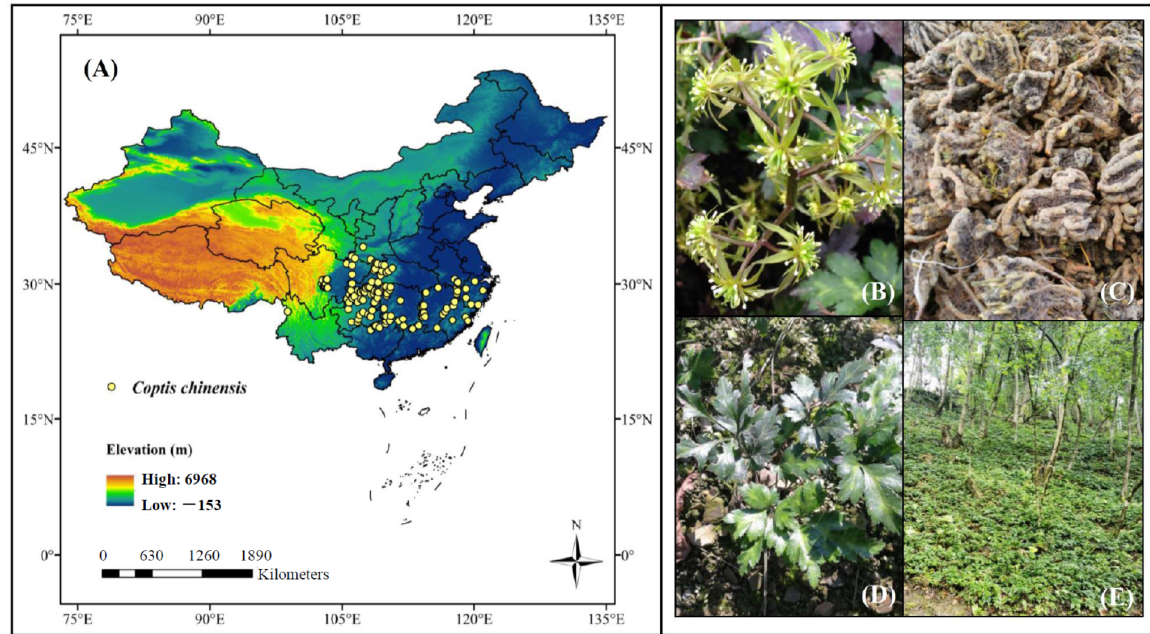
Figure 1. Photos of Coptis chinensis in the field and its distribution. ( A ) location; ( B ) flower; ( C ) rhizome; ( D ) individual; ( E ) habitat.